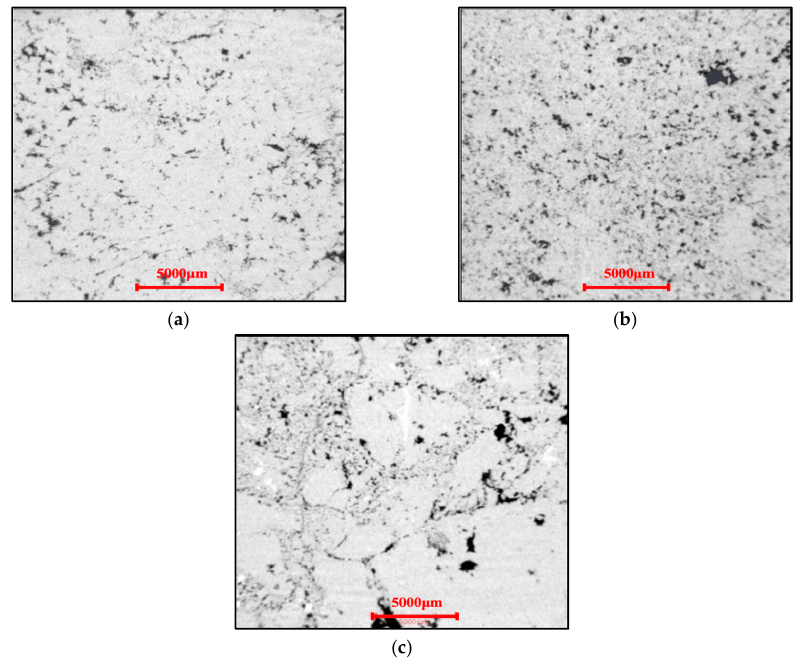
Figure 2. Optimized CT scan images: ( a ) Fracture-type; ( b ) Cavity-type; ( c ) Fracture–cavity-type.